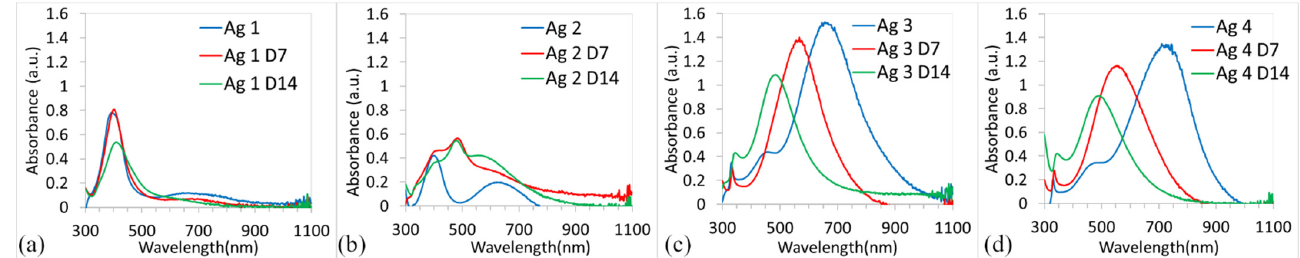
Figure 2. The stability of AgNPs with time for sample Ag 1 ( a ); sample Ag 2 ( b ); sample Ag 3 ( c ) and sample Ag 4 ( d ). The stability of AgNPs with time.